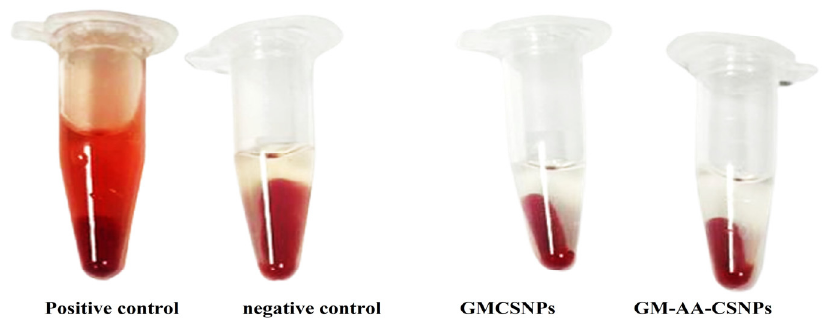
Figure 7. Hemolysis assay of GMCSNPs and GM–AA–CSNPs against the positive and negative controls.